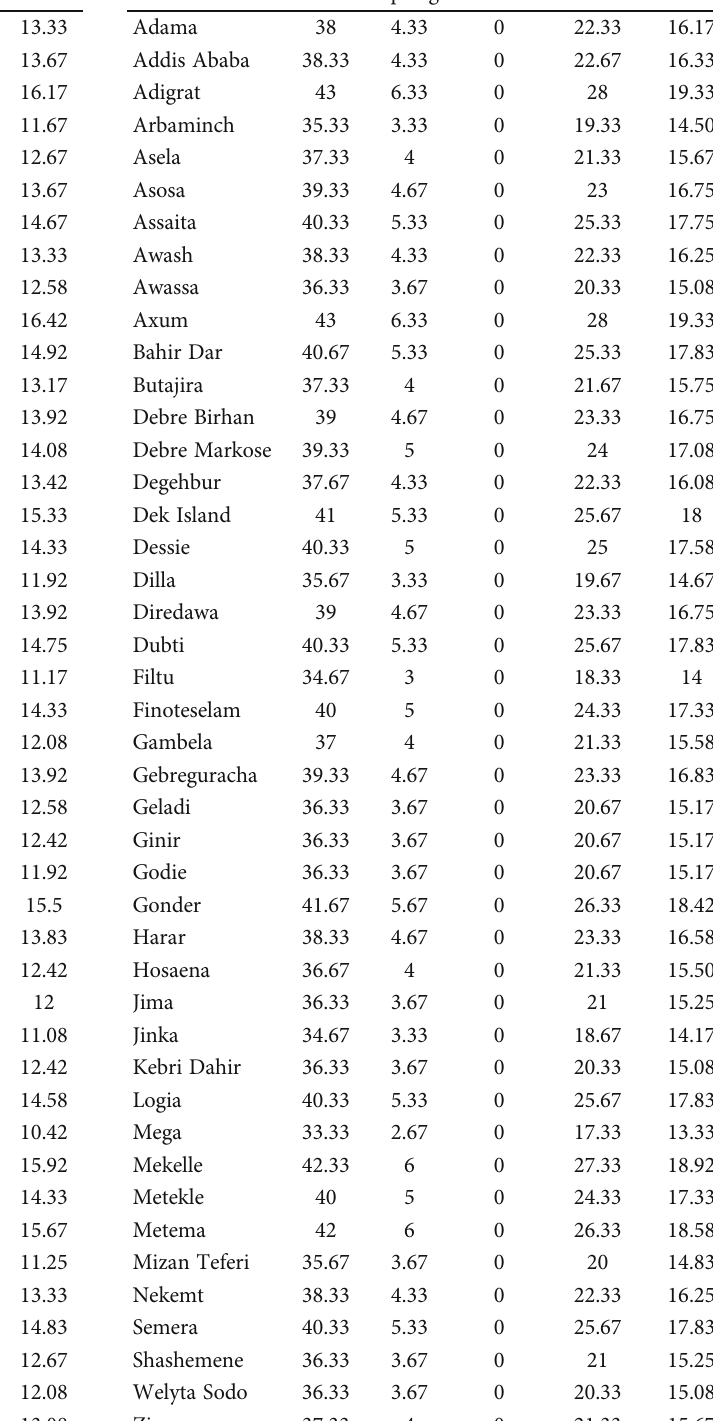
Table 3: The seasonal and yearly optimal tilt angle of 44 cities in Ethiopia using the isotropic model, equation (16).